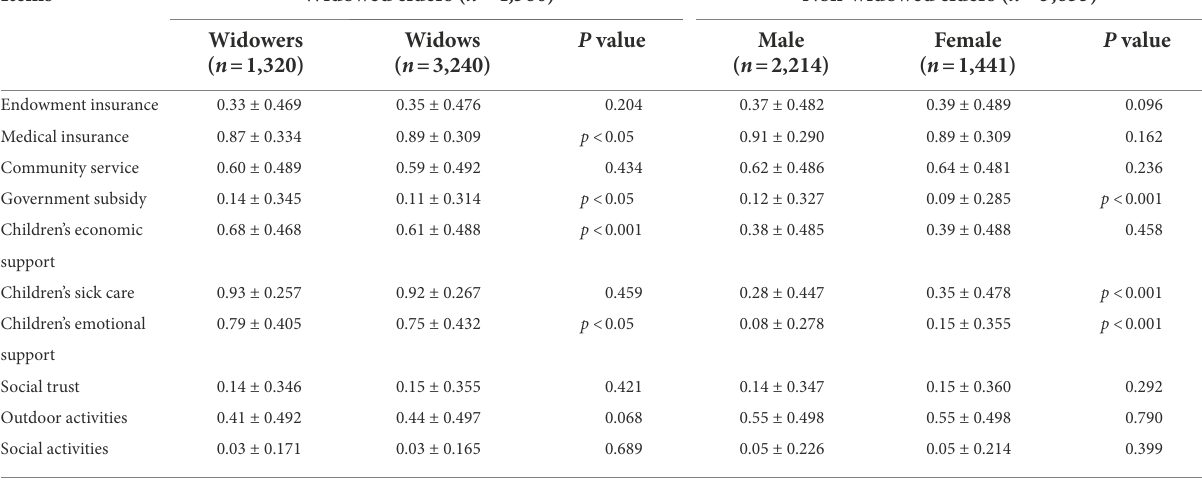
TABLE 4 Gender differences in the social support of widowed and non-widowed